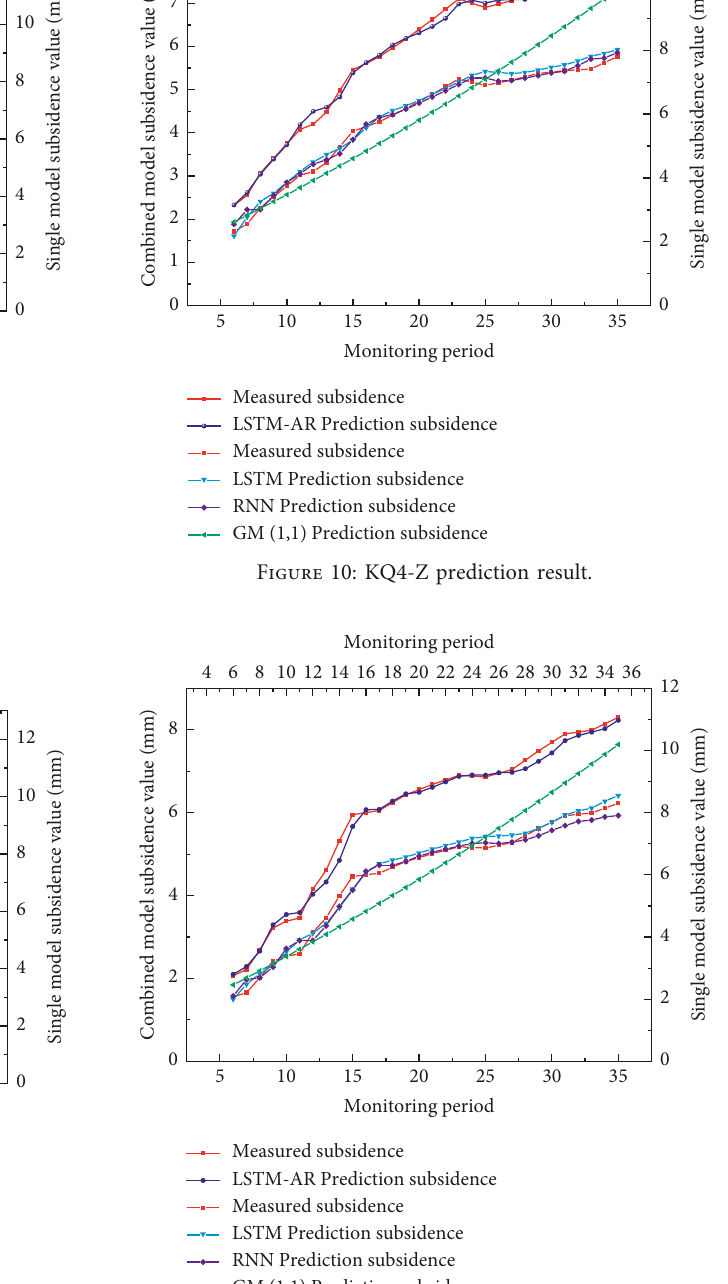
Figure 11: KQ5-Z prediction